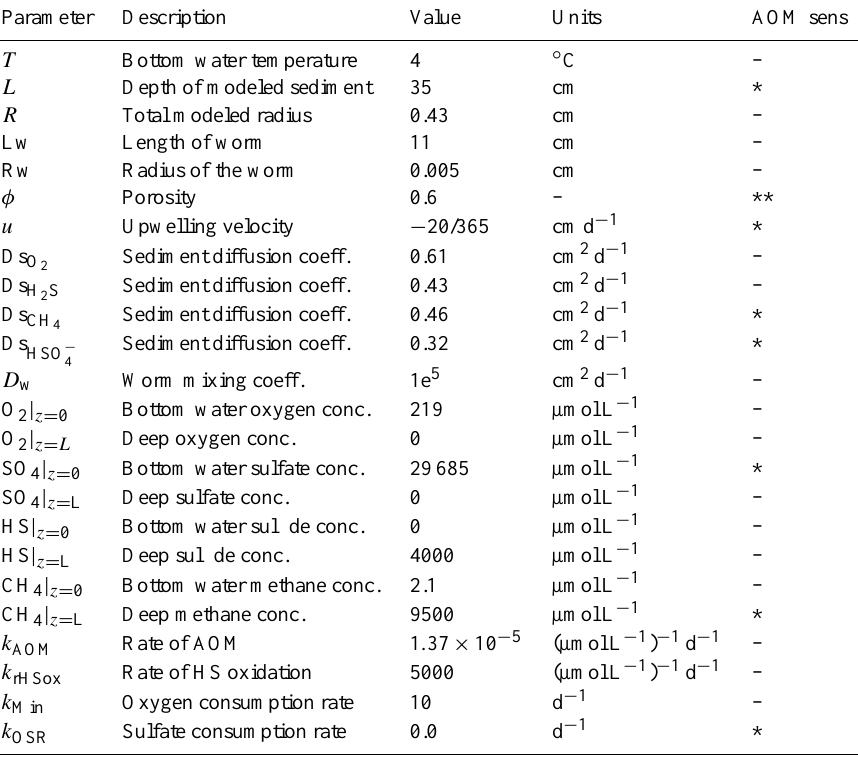
Table 1. Parameters and driving variables in the model. Last column represents the normalised sensitivity of the integrated AOM rate on each parameter, estimated as AOM